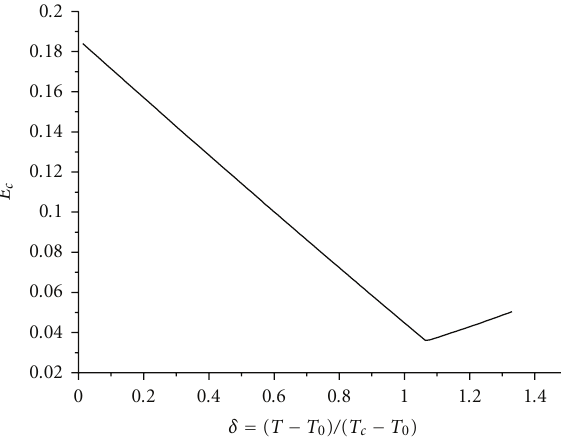
Figure 5: Dependence of the coercive field E c on the dimensionless temperature δ = ( T − T 0 ) / ( T c − T 0 ) for the system undergoing a first-order phase